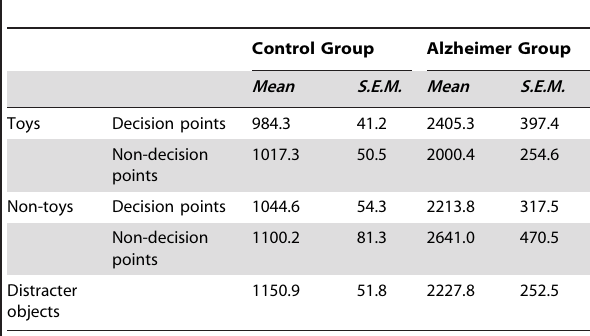
Table 1. Mean response times ( + S.E.M.) for the toys and non- toys placed at decision points or non-decision points, as well as the distracter items (correct trials